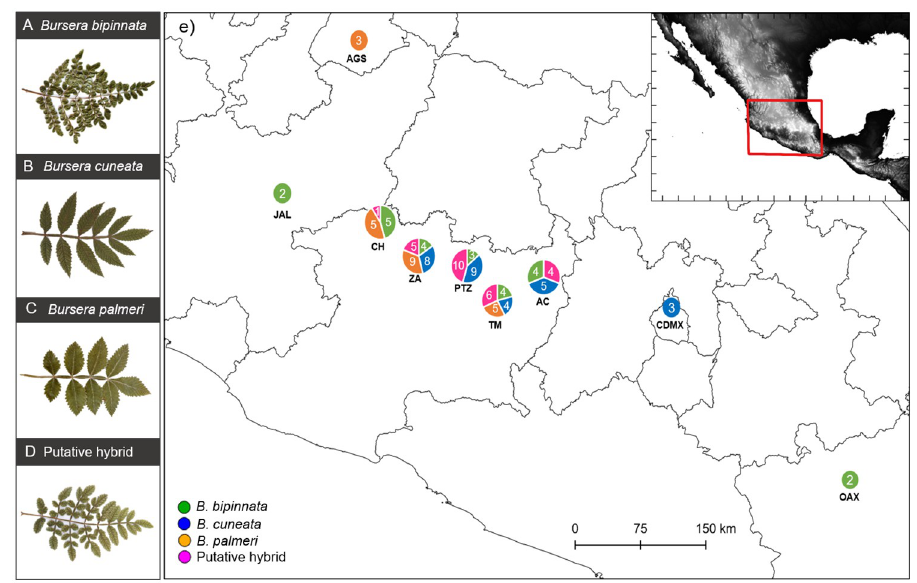
Fig 1. Leaf characteristics of (A) Bursera bipinnata , (B) B . cuneata , (C) B . palmeri and (D) putative hybrids, and (E) map of sampling localities. Numbers within circles represent the number of samples collected per each species and the putative hybrids per locality; color designations: B . bipinnata (green), B . cuneata (blue), B . palmeri (yellow), and putative hybrids (pink). Sampling localities: Aguascalientes AGS, Jalisco JAL, Churintzio CH, Zacapu ZA,